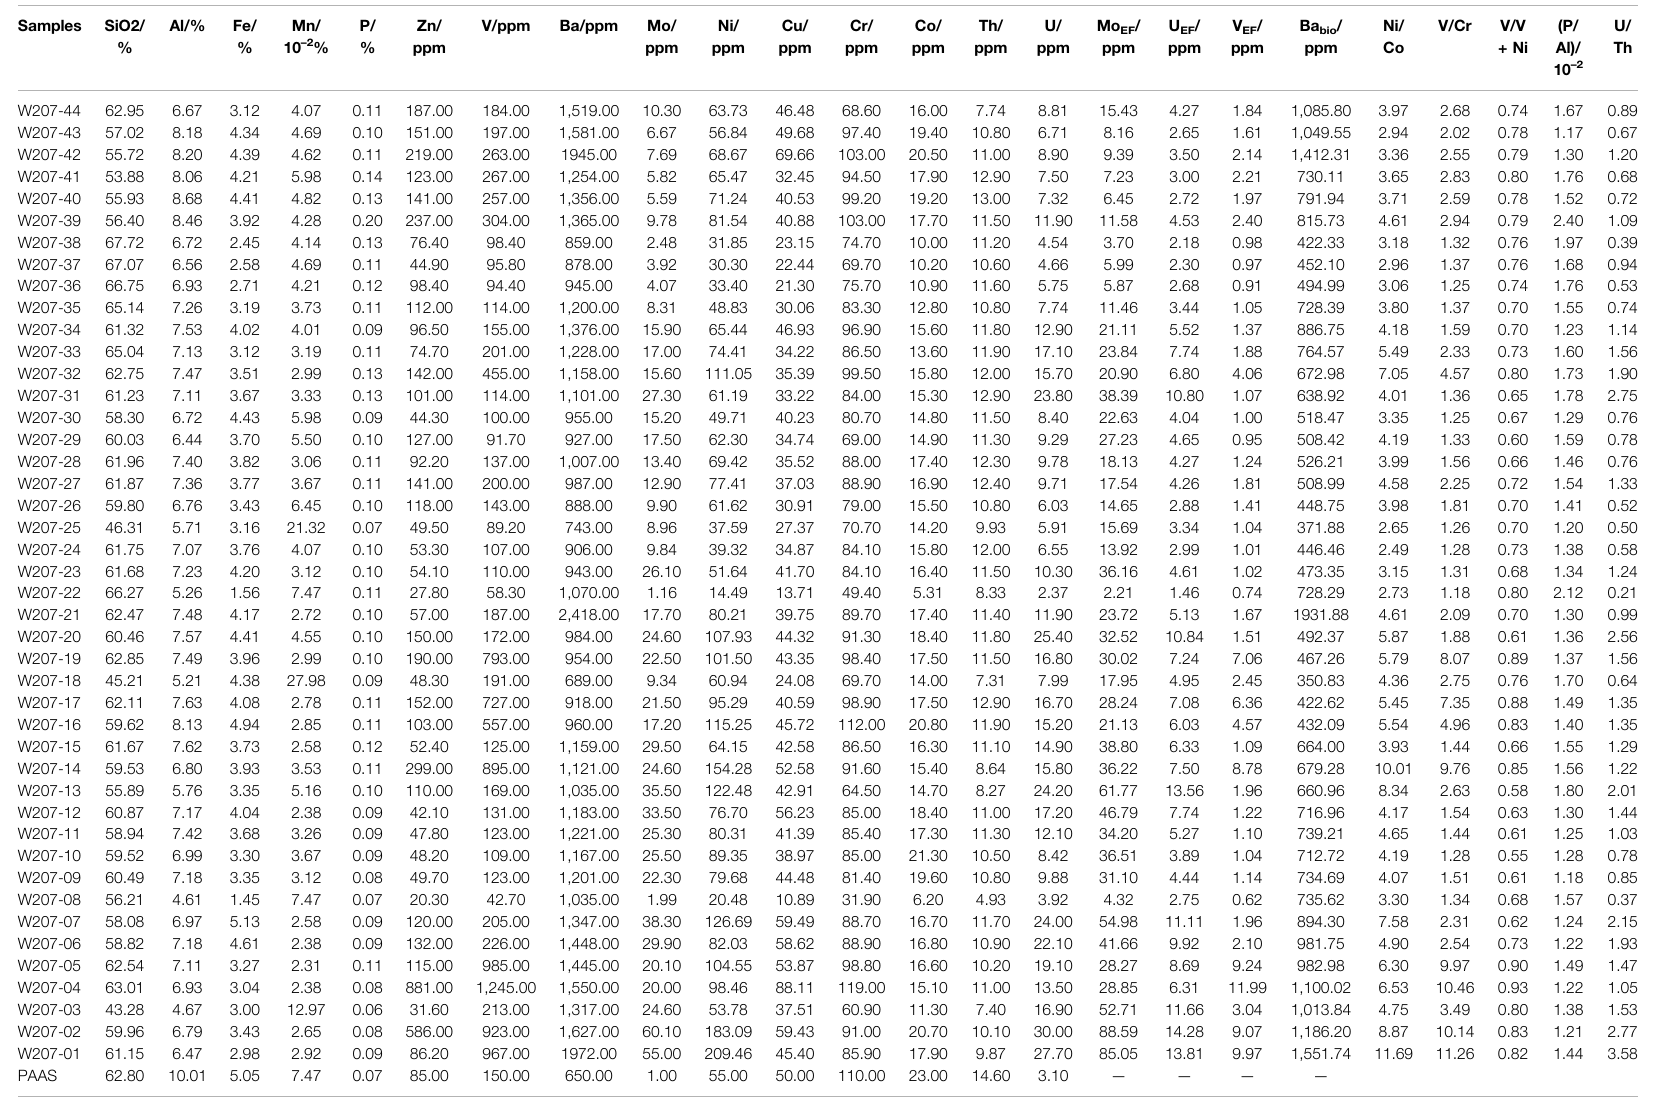
TABLE 2 | Analysis table of major and trace elements in Qiongzhusi Fm, W-207 Well. Samples SiO2/ %